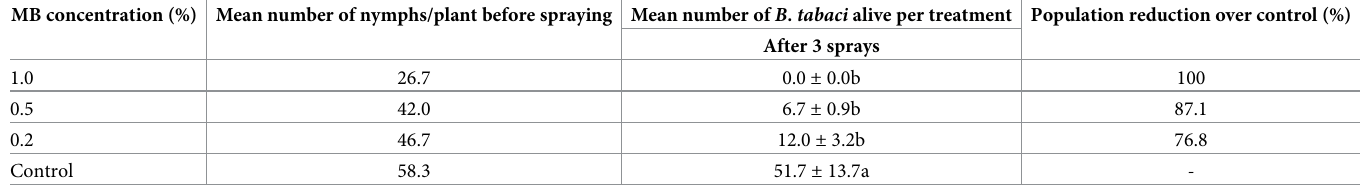
Data are presented as means ± SE (n = 3). Means followed by same letters are not significantly different within a single column, based on one-way ANOVA and Tukey’s HSD post-hoc test ( P <